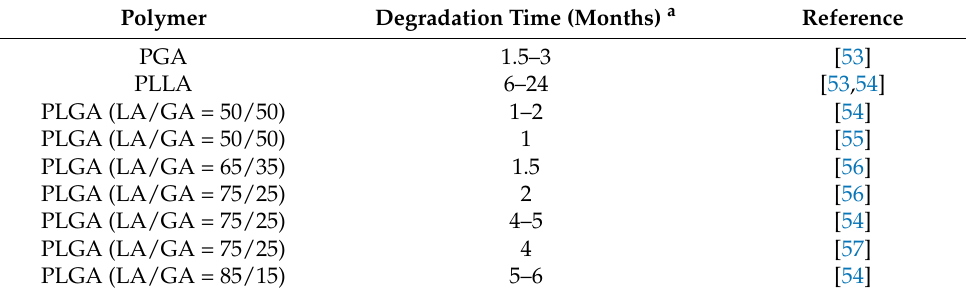
Figure 15. Chemical structure of LA, LG, and PLGA [53]. Table 2. Degradation time of PGA, PLLA, and its copolymers.